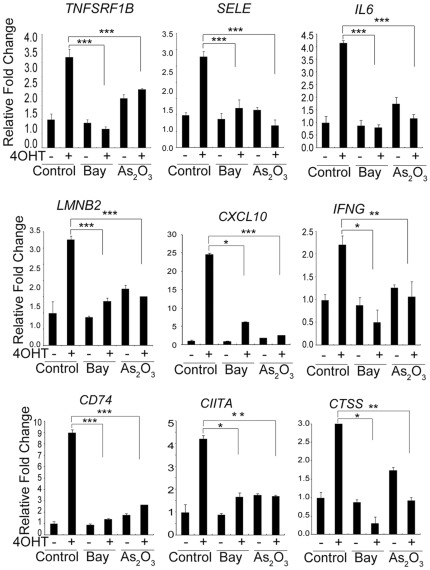
NF-κB inhibitors block K13-regulated genes.BCBL1 K13-ERTAM cells were treated with two NF–κB inhibitors (2 µM Bay 11-7082 or 2 µM As2O3) for 2 hours followed by 4OHT treatment for additional 24 hours and total RNA was isolated as described in the Materials and Method section. Nine genes were randomly picked and their relative mRNA levels were examined using real-time RT-PCR as explained in Figure 2A.